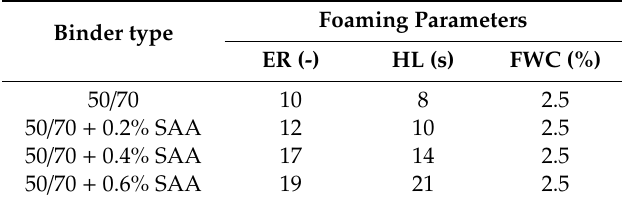
Table 12. Foamed 50 / 70 bitumen parameters versus binder type and additive